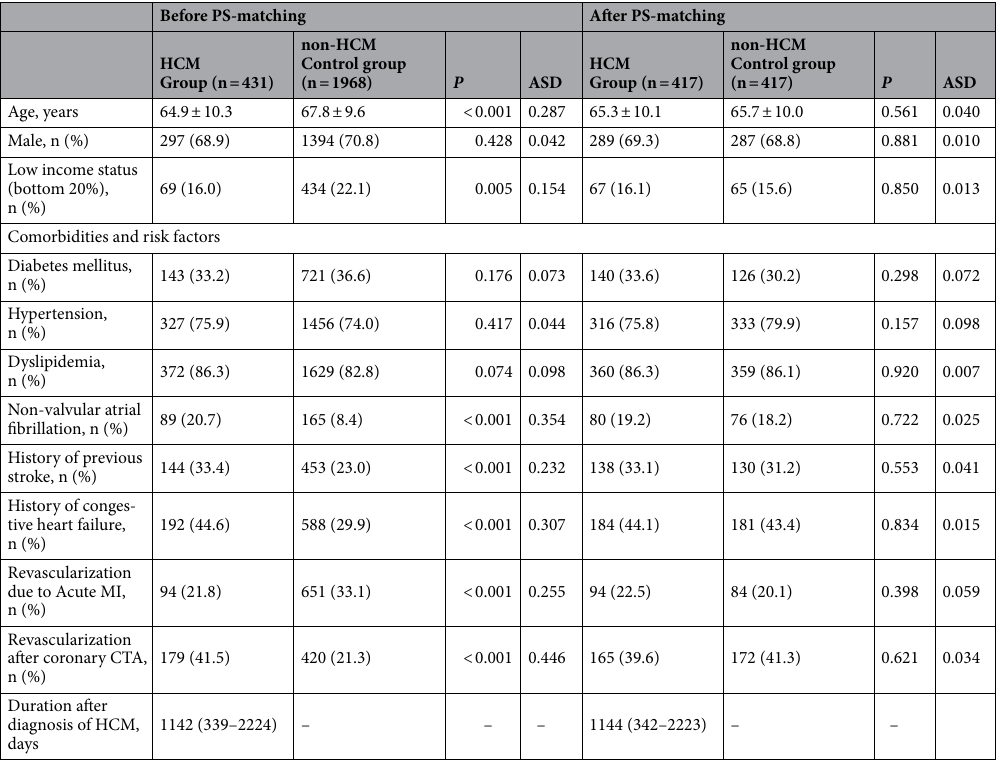
Table 1. Baseline characteristics of before and after propensity-score matched population. Abbreviations: ASD, absolute standardized difference; CTA, computed tomography angiography; eGFR, estimated glomerular filtration rate; HCM, hypertrophic cardiomyopathy; MI, myocardial infarction; PS, propensity